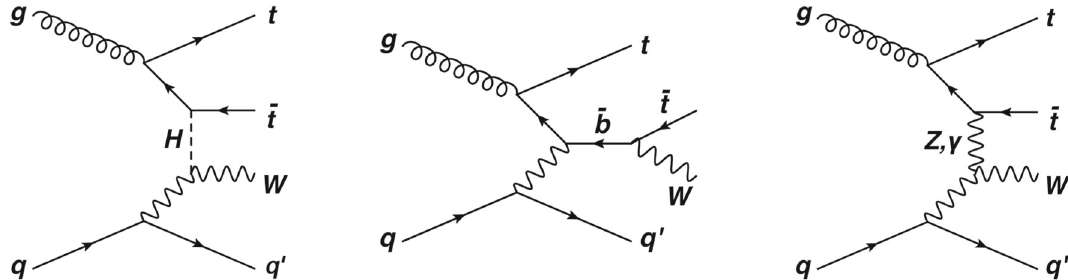
Fig. 4 Dominant representative Feynman diagrams for the EW sub contributions in the α s α 3 perturbative order